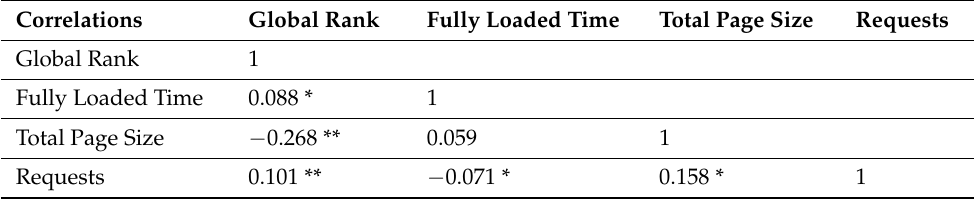
Table 11. Coefficients between the examined metrics for H5. Correlations Global Rank Fully Loaded Time Total Page Size